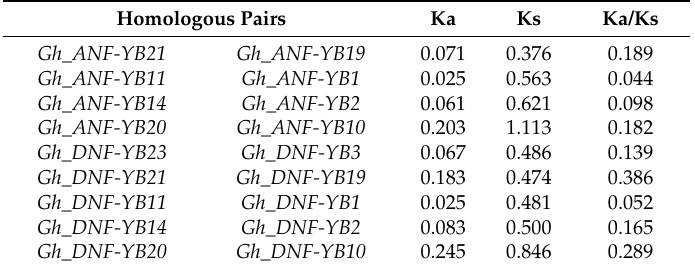
Figure 2. Collinearity analyses of Gossypium hirsutum NF-YB genes. A01–13 and D01–13 represent chromosomes from the A and D sub-genomes, respectively. The red lines link two genes that were identified to be homologous chromosome pairs from the A t and D t sub-genomes. The grey lines link gene pairs formed by segmental duplication within the A t and D t sub-genomes. Table 1. Comparative analysis of Ka, Ks, and Ka/Ks values for homologous pairs in Gossypium hirsutum . Homologous